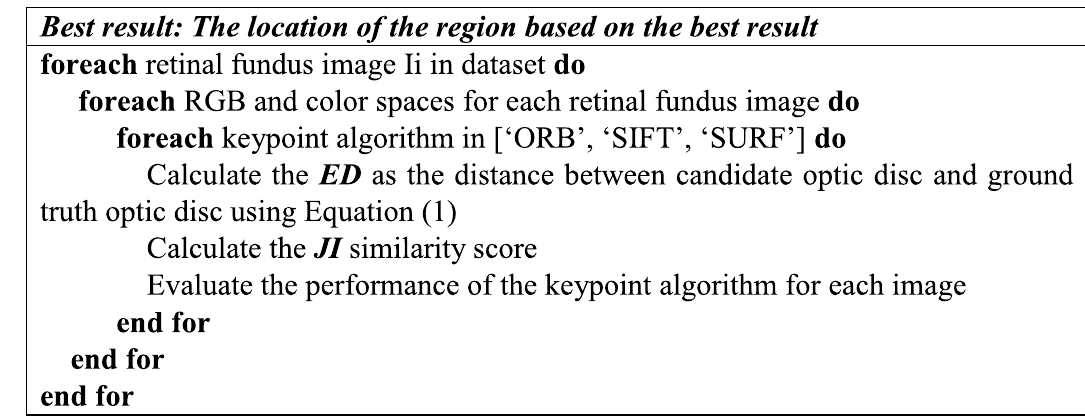
One of the following three cases was assigned to each retinal image automatically in the proposed